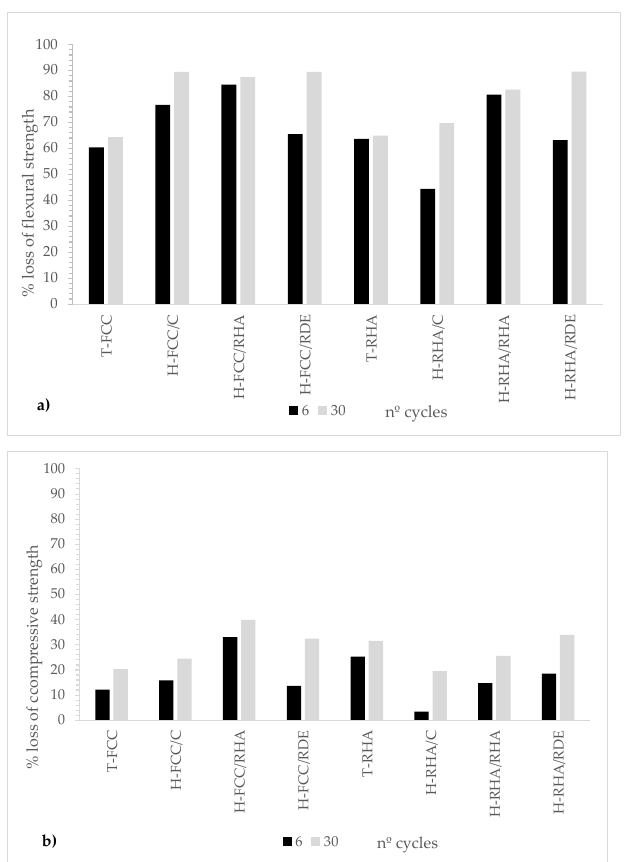
Figure 6. Mechanical properties after freeze–thaw cycles: ( a ) percentage of loss in flexural strength; ( b ) percentage of loss in compressive strength.